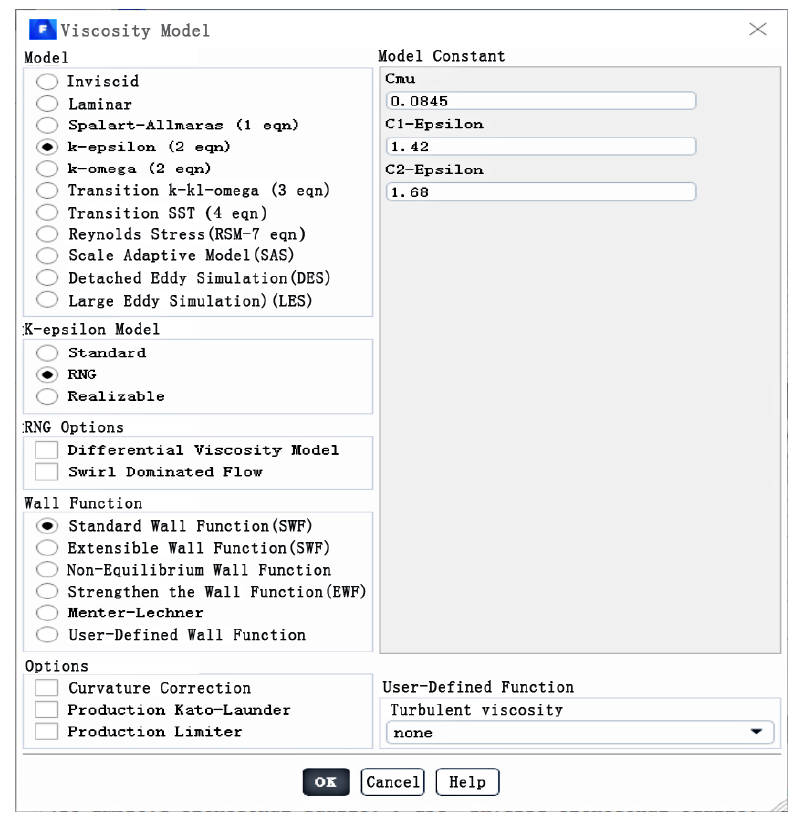
Figure 9. Viscosity model selection dialog.